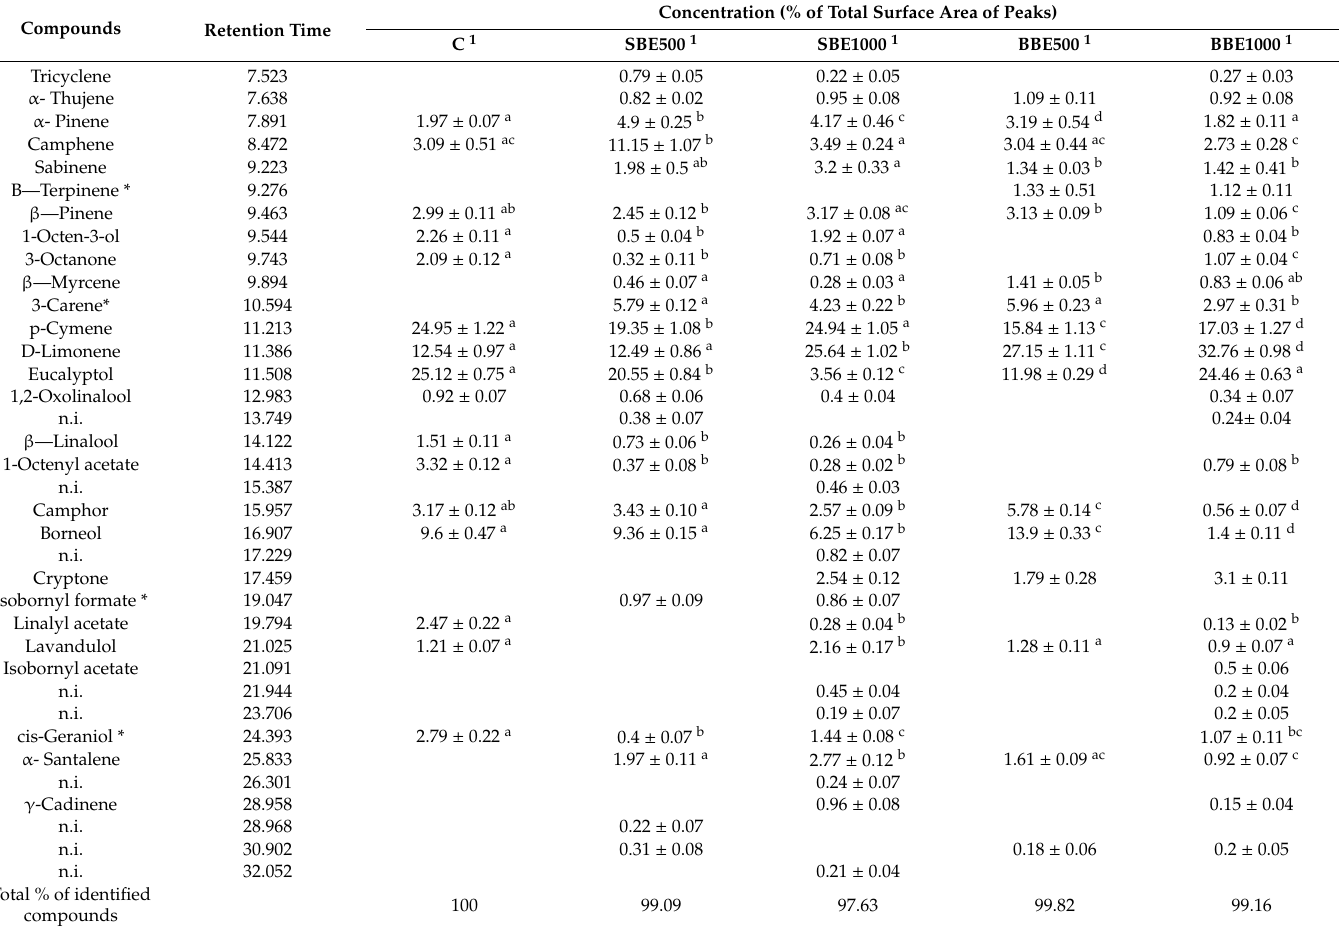
Table 5. Voil composition of lavender